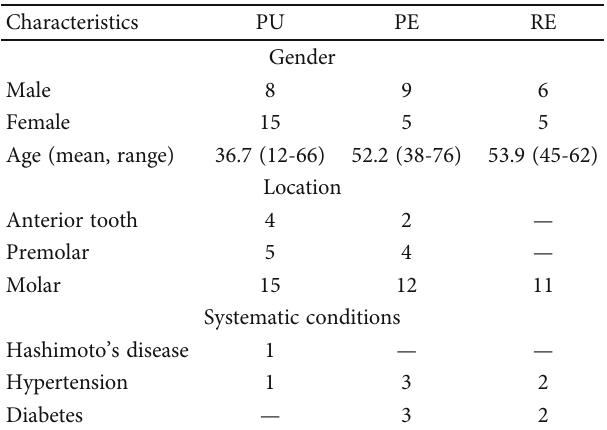
Table 2: Study population characteristics.